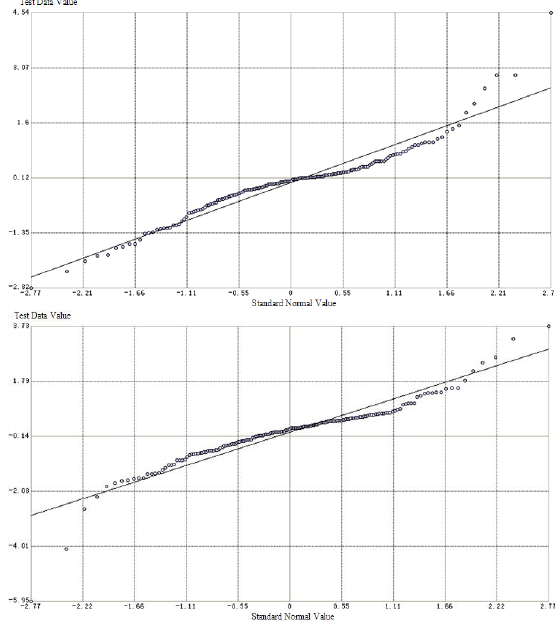
Figure 3. Comparison between check-in data error distribution and normal